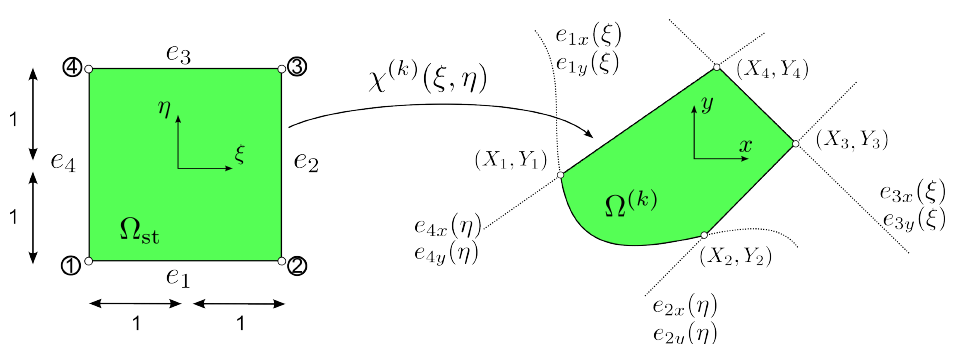
Figure 3. Element mapping procedure.